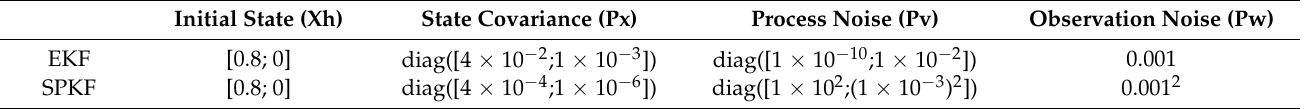
Table 3. The parameters of EKF and SPKF for model 2.